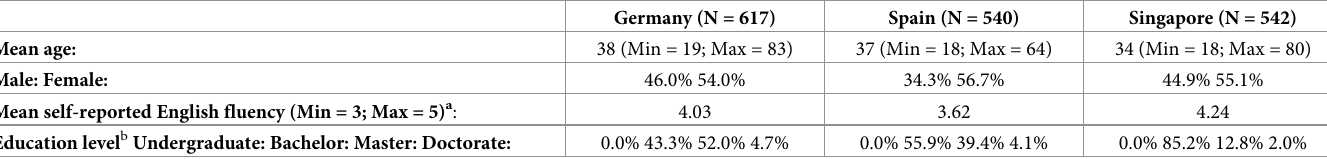
Table 1. Listeners (N = 1699): Age, % sex, self-reported English fluency, education